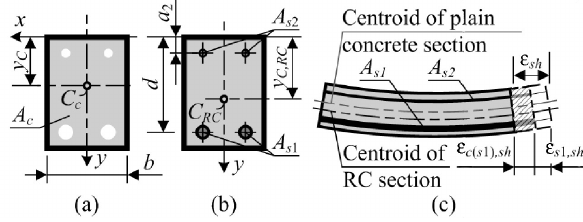
Fig. 6. Deformations of asymmetrically RC member due to shrinkage (Gribniak et al . 2007): a – plain concrete net section; b – asymmetrically reinforced section; c – defor- mations in asymmetrically reinforced element due to re- strained